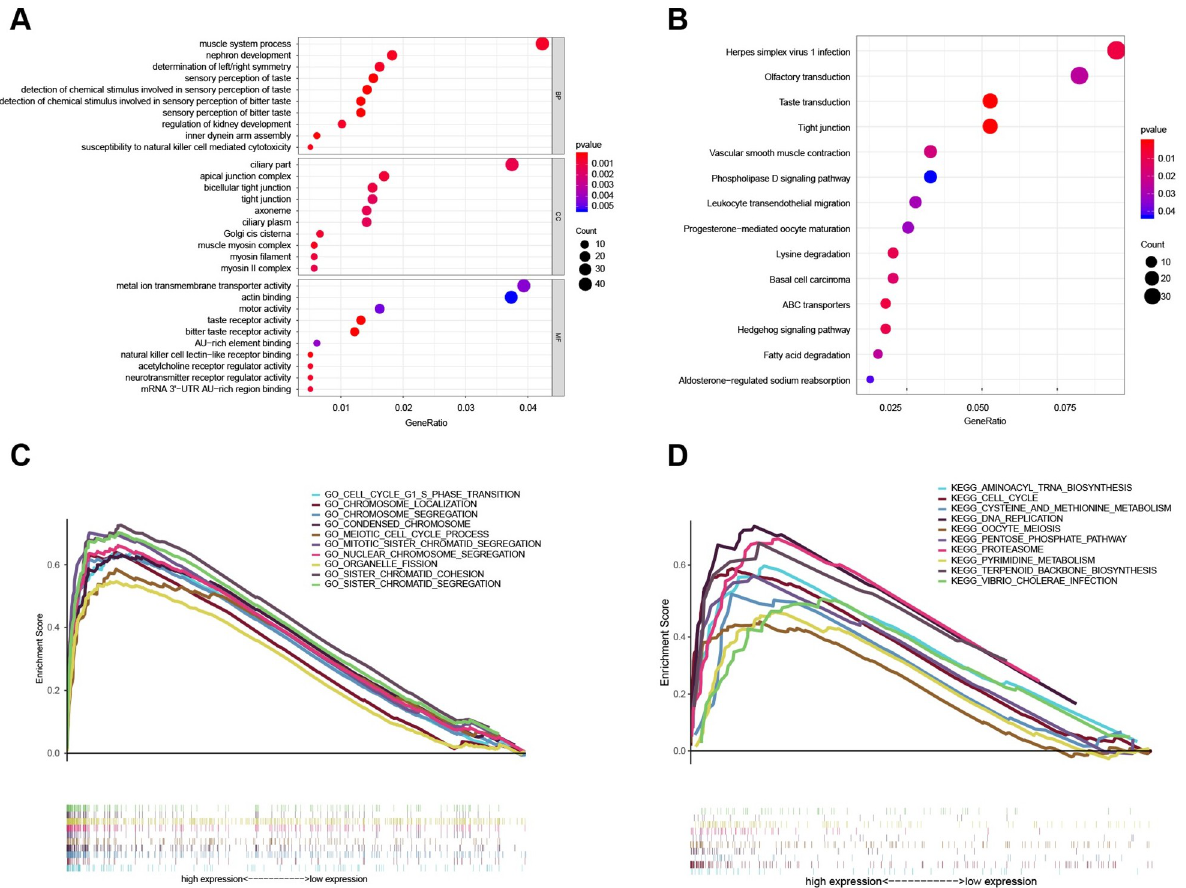
Fig 2. The functional enrichment analysis of the 8-lncRNA signature. (A) GO enrichment analysis, including MF, BP, and CC. (B) The result of KEGG enrichment analysis. (C), (D) GSEA-GO/KEGG enrichment analysis. GO: gene ontology; MF: molecular function; CC: cellular composition; BP: biological process; KEGG: Kyoto Encyclopedia of Genes and Genomes. GSEA: gene set enrichment analysis; BCa: breast cancer.